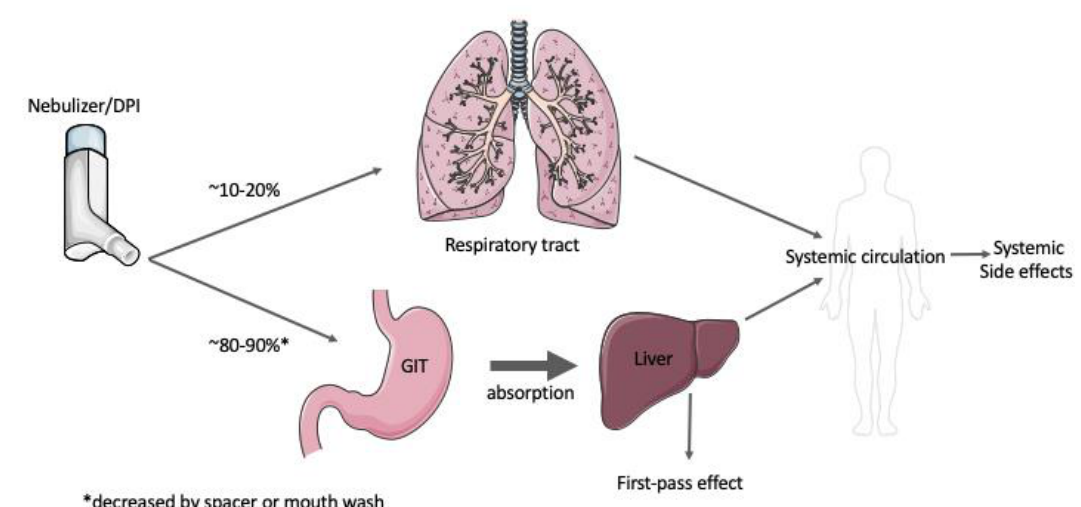
Figure 1. Schematic overview of pharmacokinetics of inhaled drugs .